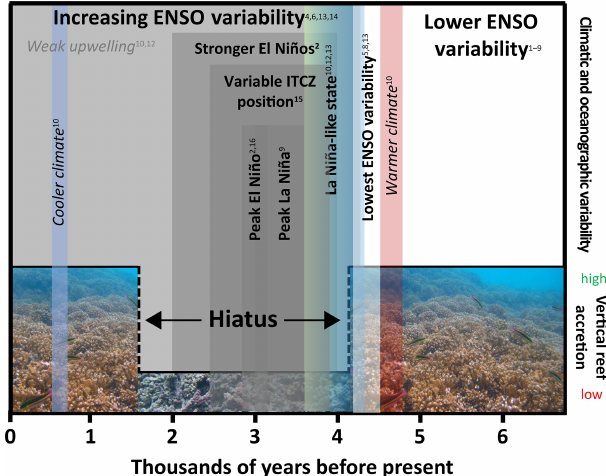
Figure 3. Schematic diagram of the reconstructed changes in ENSO variability in the tropical Pacific in relation to vertical reef accretion in Pacific Panama. Colored bars are based on a paleo- ceanographic reconstruction from Pacific Panama shown in Fig. 2; gray bars summarize the results of other paleoclimate studies from throughout the tropical Pacific. Superscripts reference the studies that support the climatic and oceanographic changes indicated in the bars: (1) Sandweiss et al. (2001); (2) Rein et al. (2005); (3) Zheng et al. (2008); (4) Koutavas and Joanides (2012); (5) Cobb et al. (2013); (6) Carré et al. (2014); (7) Emile-Geay et al. (2016); (8) Leonard et al. (2016b); (9) Thompson et al. (2017); (10) Toth et al. (2015a); (11) McGregor et al. (2013); (12) Toth et al. (2015b); (13) Conroy et al. (2008); (14) Corrège et al. (2000); (15) Haug et al. (2001); (16) Moy et al.